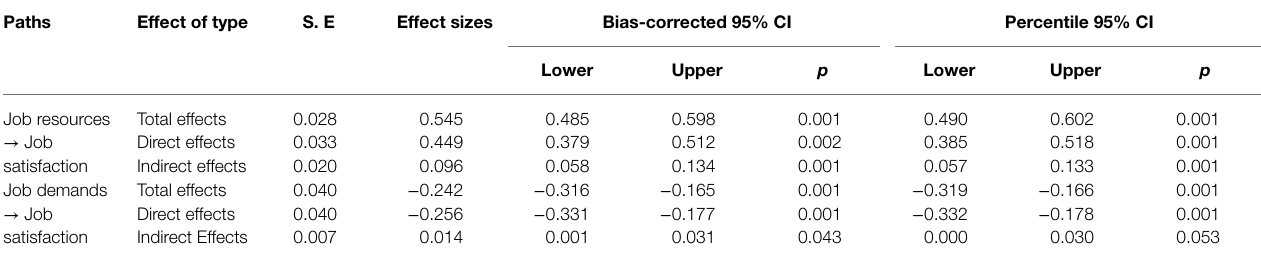
TABLE 8 | Examining the mediating effect with Bootstrap method (standardized coefficients).